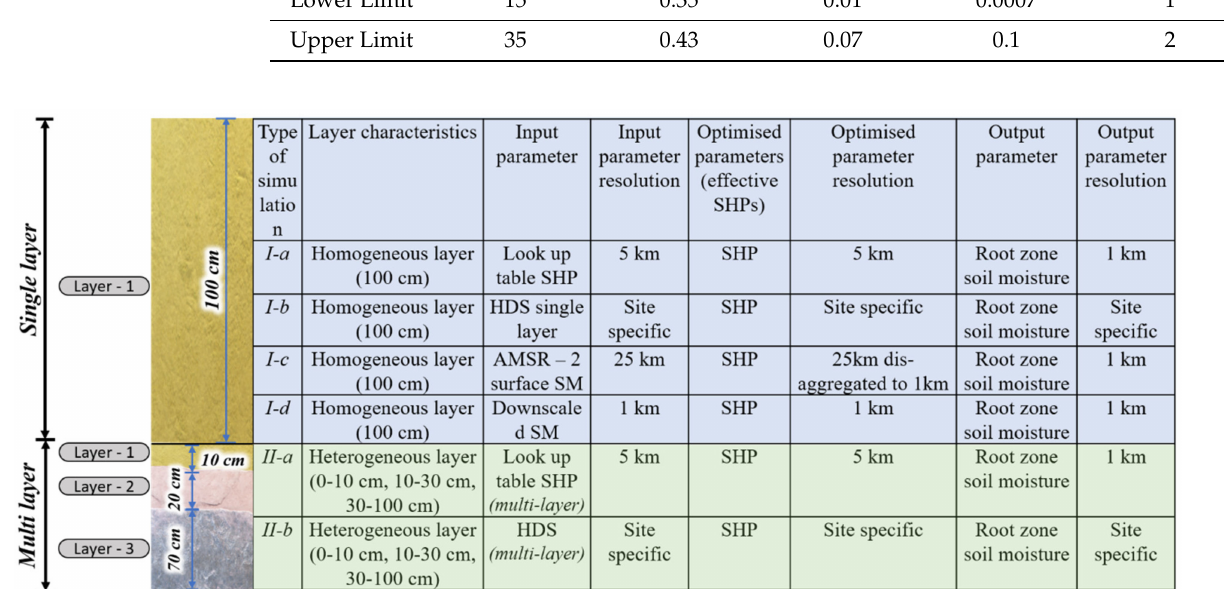
Figure 5. Details of the experiments with the input data sets, based on which the SHPs are optimized. Model Initial and Boundary